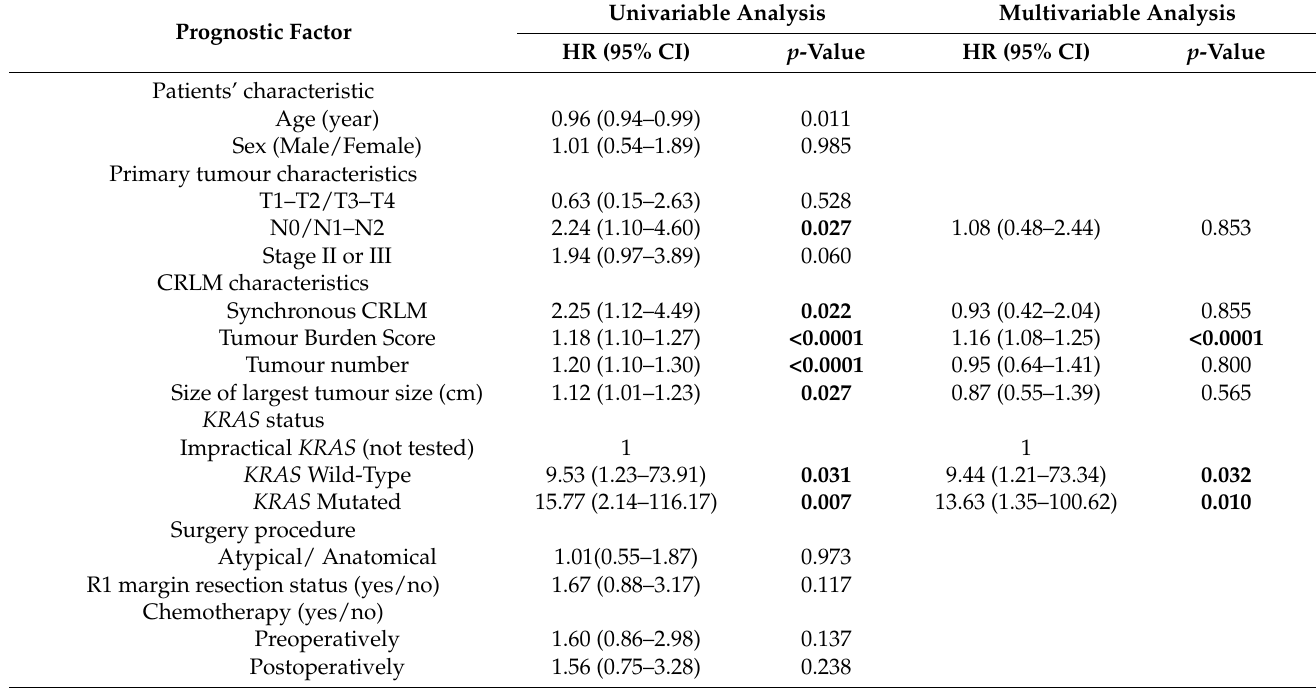
Table 3. Uni-and Multivariable Predictors of Hepatic Recurrence in the Entire